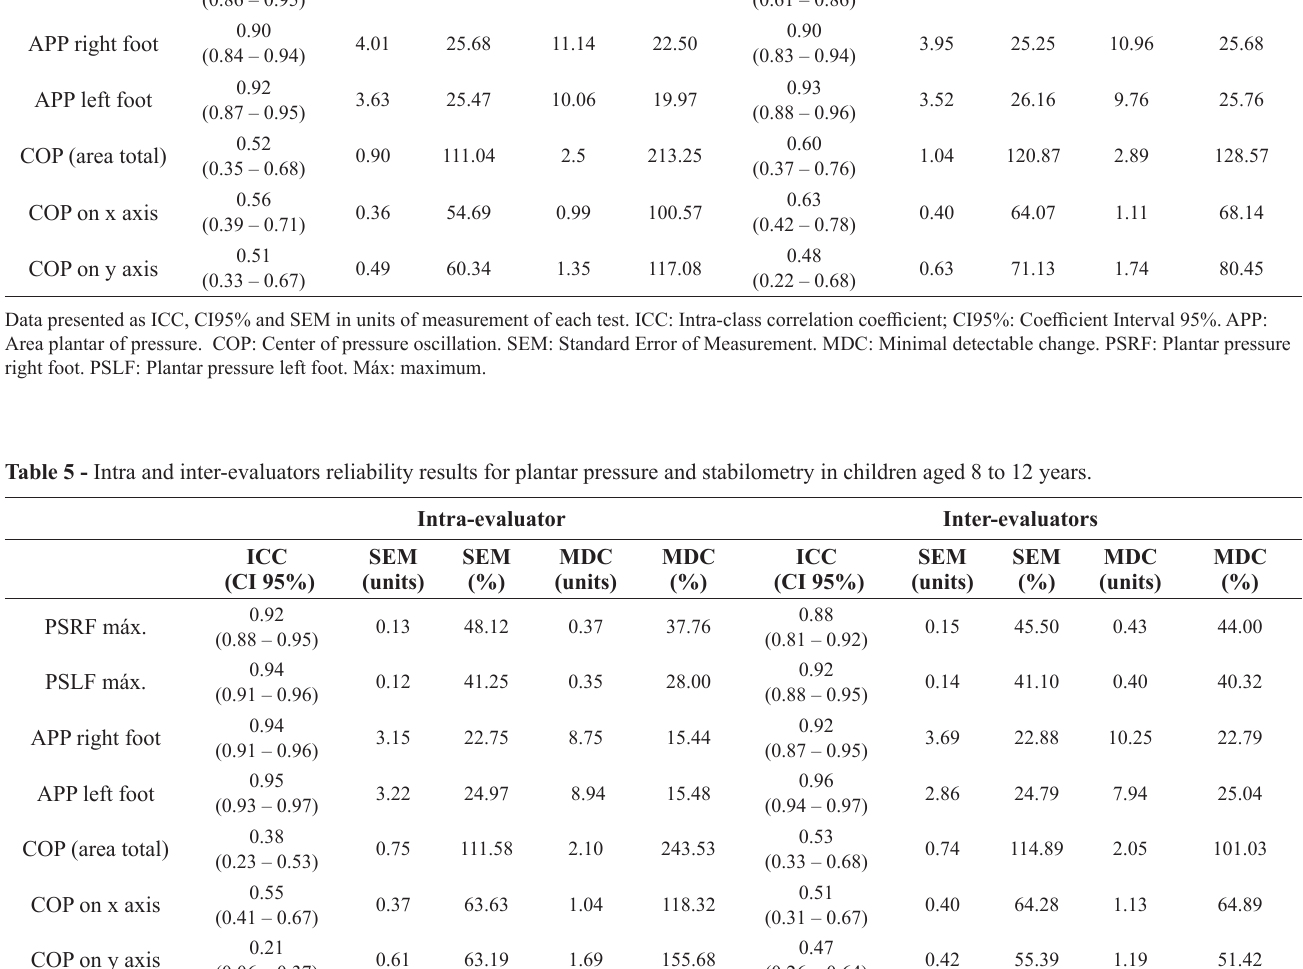
PSRF máx. PSLF máx.